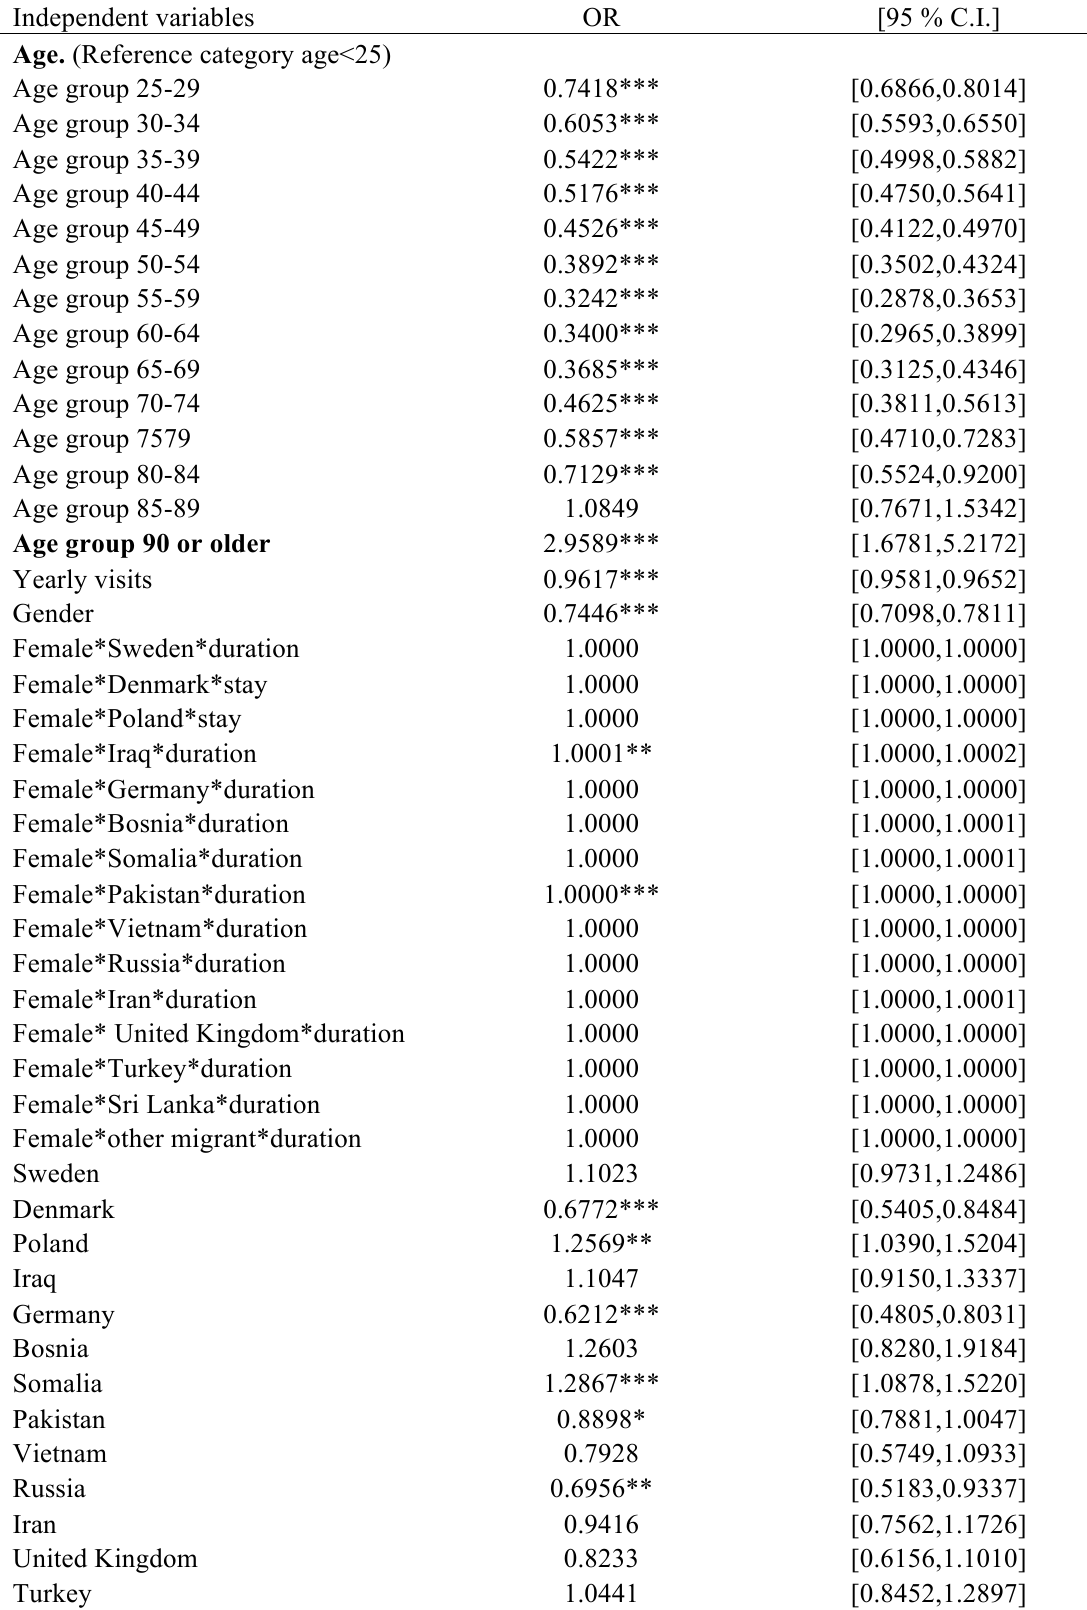
Table 3: The estimated impact of duration of residence among individuals with different birth countries, on the probability of seeking care at the EW. Results from random effects logistic regression. Independent variables OR [95 %